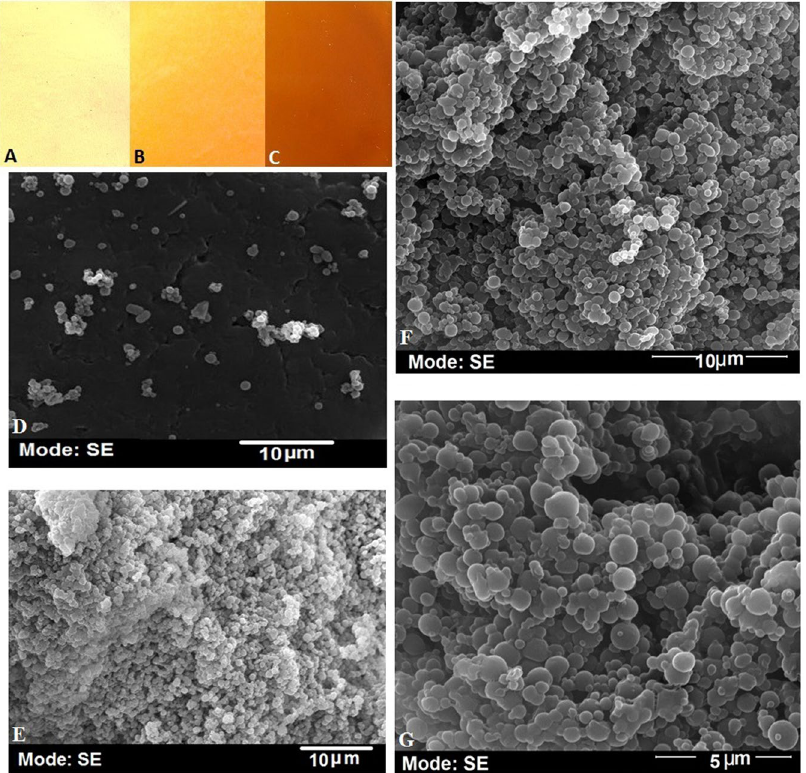
Figure 5. Visual appearance of the film ( A ) film prepared using increased PHB 2% and 1% each of Nm ( B ) film made using equal proportionate of Nm, PHB and glycerol and PHB ( C ) film casted using increased concentration of Nm 2% and 1% each of PHB and glycerol. SEM Imaging of films - ( D ) corresponds to the image of film using increased concentration of Nm with equal amount of PHB and glycerol of 1%. ( E ) Shows the